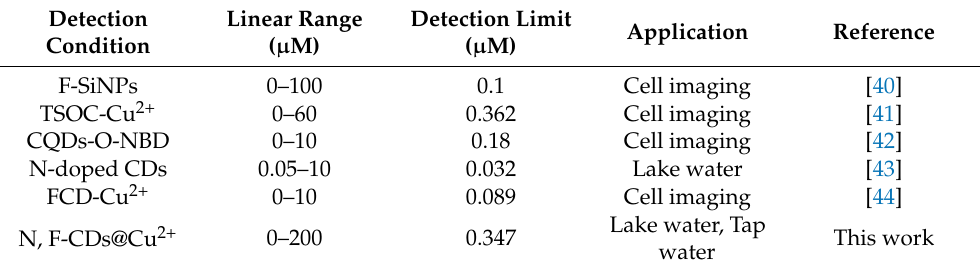
Table 2. Comparison of different optical methods applied for the determination of S 2 −